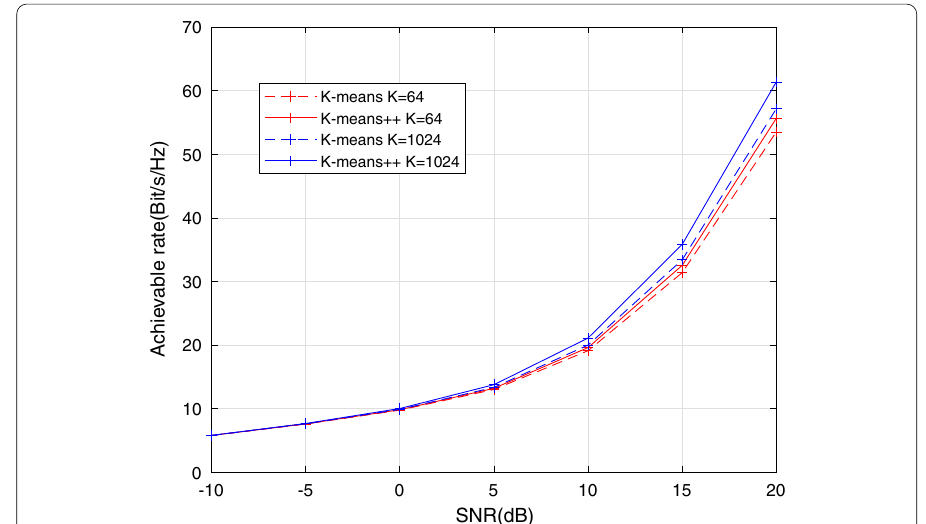
Fig. 4 Achievable rate of proposed codebook with different clustering algorithms